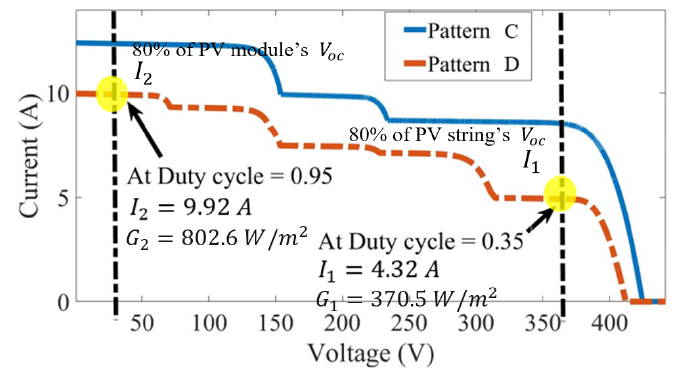
Figure 8. Example current-voltage (I-V) characteristic curves for patterns C and D.